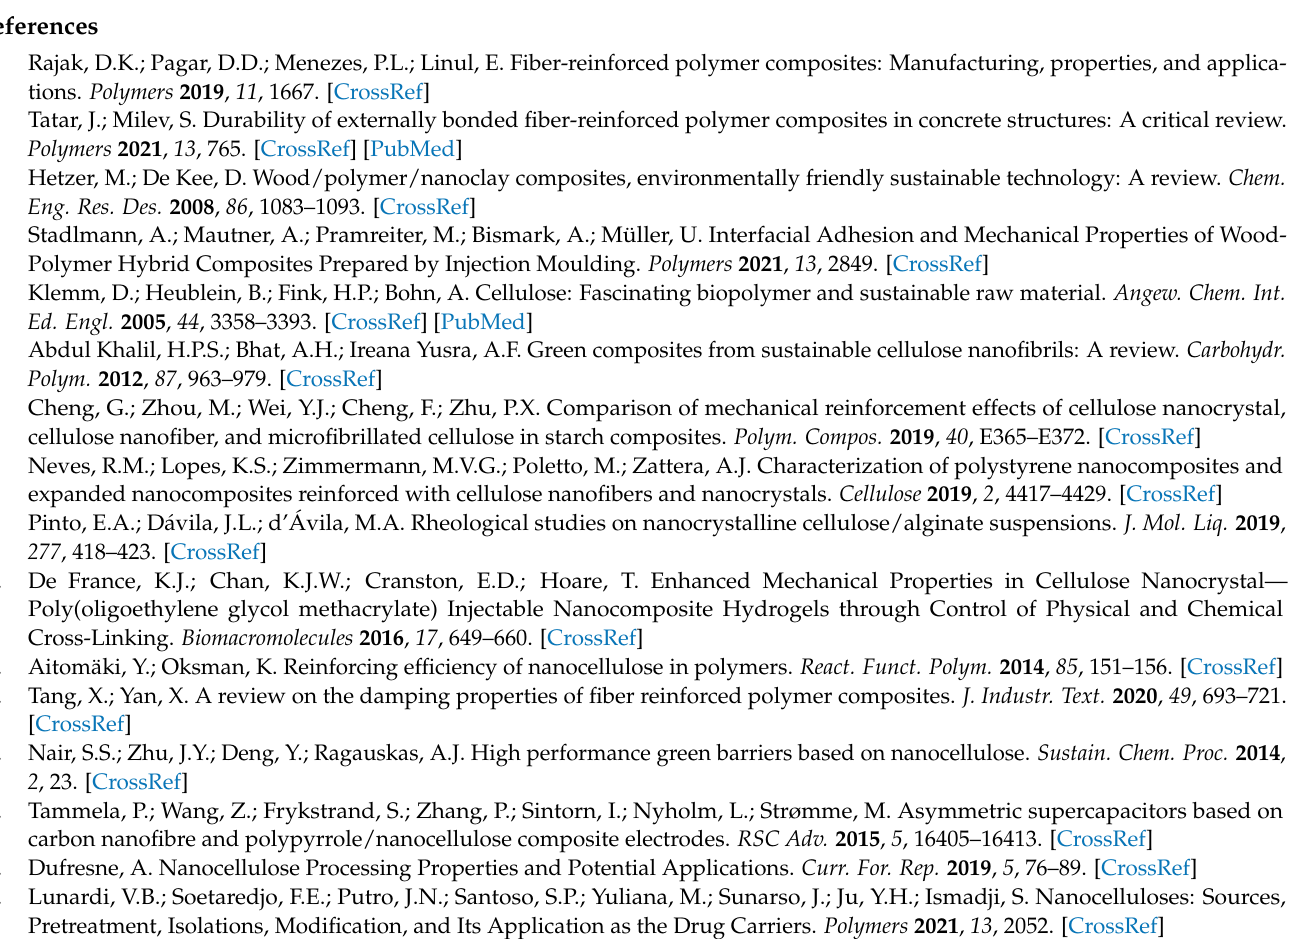
materials; Table S1: Molecular mass and dispersity index (Ð) of non-crosslinked PSt extracted from cellobiose-m (CB-PSt), cellotriose-m (CTR-PSt), Sigmacell-m (CELL-PSt) gels and of PSt polymerized in a presence of a non-modified carbohydrate